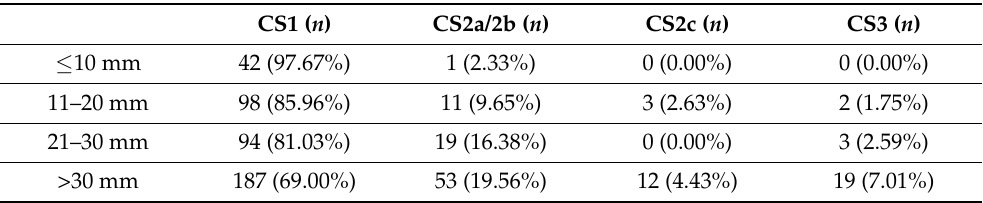
Table 7. Frequency distribution of clinical stages (CS) of germ cell tumours stratified by four categories of increasing tumour size.